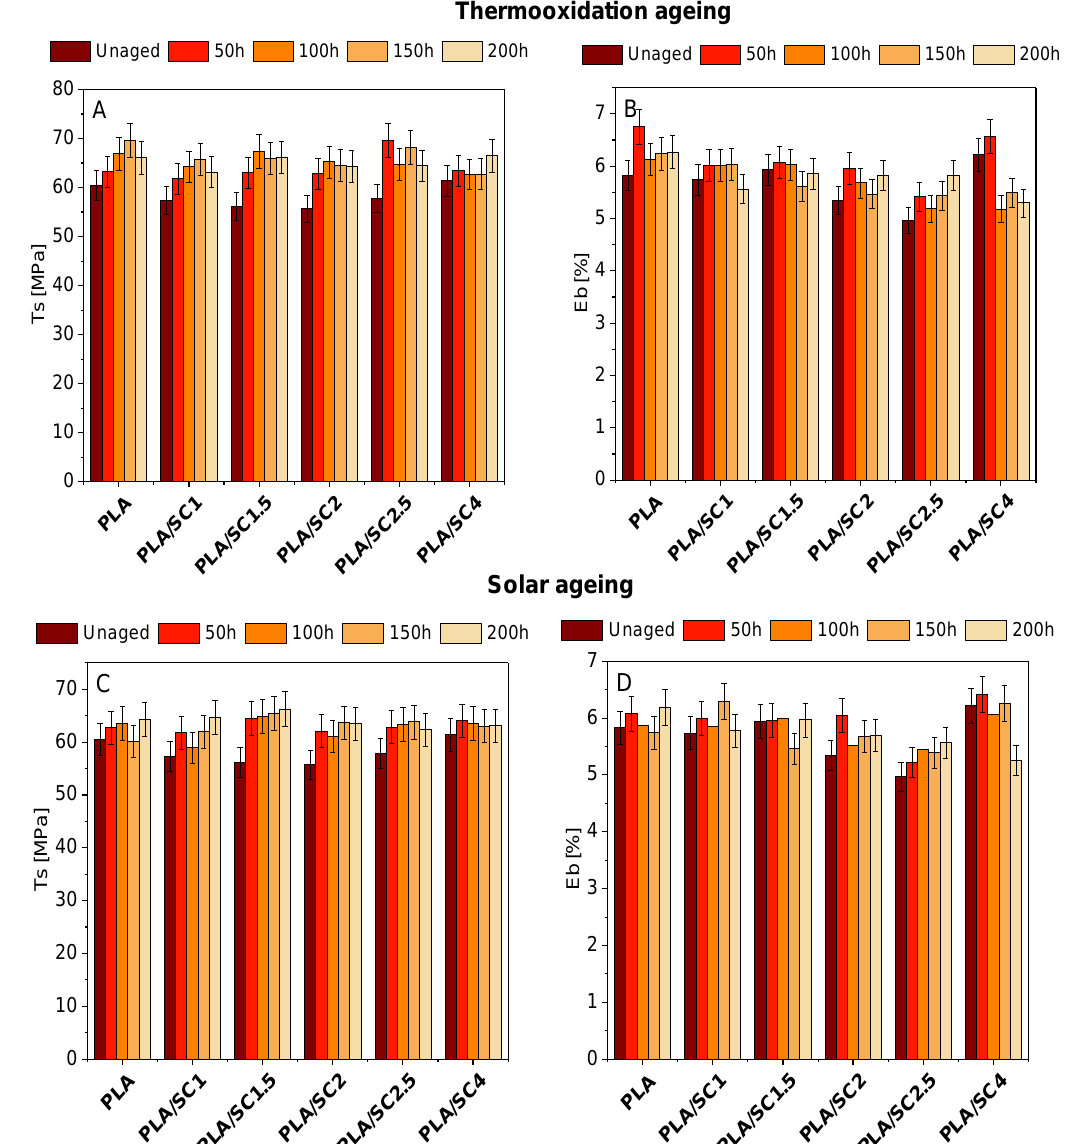
Figure 5. The changes in PLA mechanical properties (T s , the tensile strength, and E b , the elongation at break) before and after thermooxidation ( A , B ) and solar aging ( C , D ).